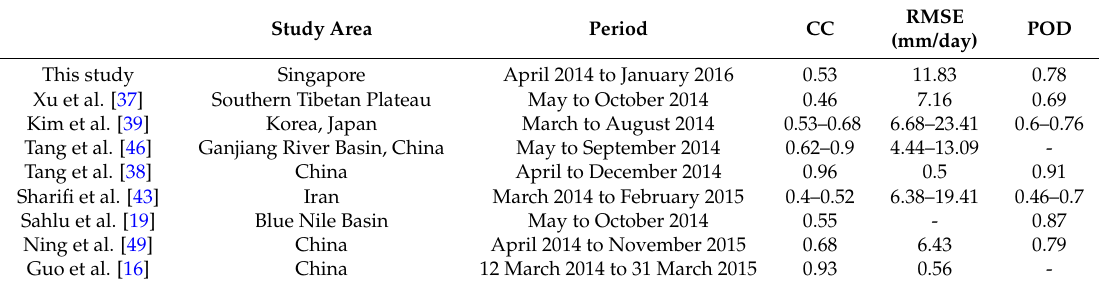
Table 3. Comparison with other IMERG evaluation studies at daily scale